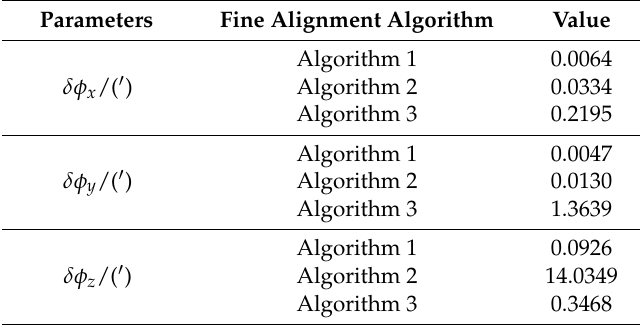
( c )  ; ( b ) Estimation errors Figure 6. Estimation errors of G  in experiment: ( a ) Estimation errors of G x Figure 6. Estimation errors of φ G in experiment: ( a ) Estimation errors of φ G x ; ( b ) Estimation errors of  . of G  ; ( c ) Estimation errors of G z y φ G y ; ( c ) Estimation errors of φ G z . Table 6 expresses the statistical results of fine alignment in experiment. Table 6. Estimation errors (RMS) of fine alignment algorithms in experiment. Table 6. Estimation errors (RMS) of fine alignment algorithms in experiment.